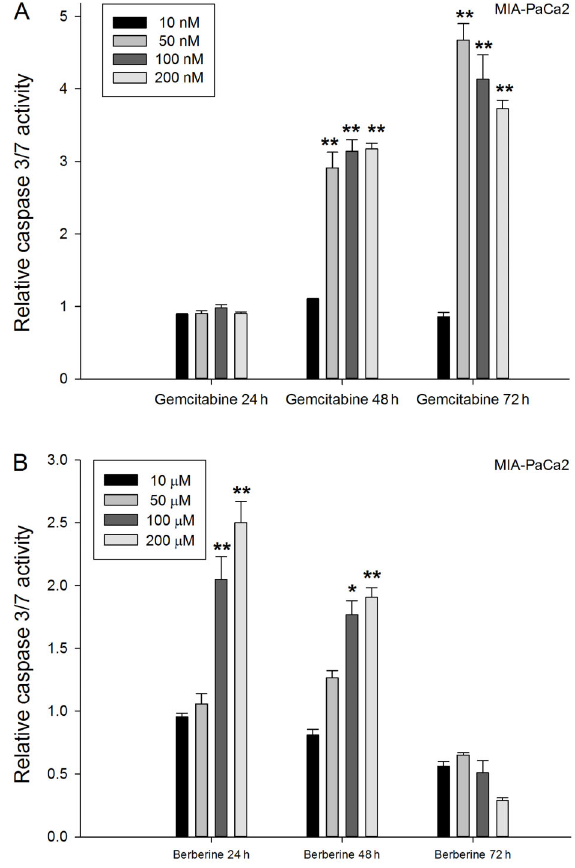
Figure 8. Intracellular reactive oxygen species (ROS) levels after 72-h gemcitabine ( A ) and berberine ( B ) treatment. Data are reported as means±SD activity (n > 3) relative to control. DCFH- DA: 2 9 ,7 9 -dichlorofluorescein diacetate. **P , 0.01 versus control (Student’s t